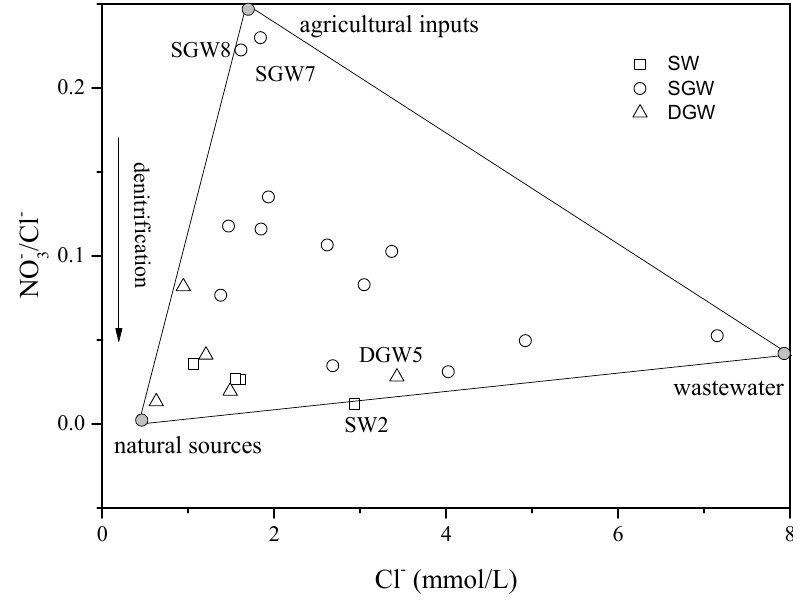
Figure 11. Variations of NO (cid:2871)(cid:2879) /Cl − molar ratios with Cl − molar concentrations of surface water and groundwater. The solid lines represent the theoretical mixing lines constructed by using the manure, municipal wastewater, and precipitation as end members. (SW: Surface water; SGW: Shallow groundwater; DGW: Deep